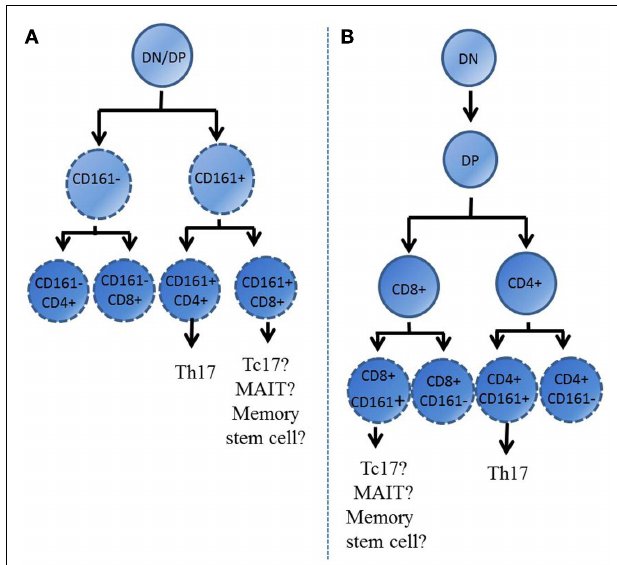
FIGURE 3 | Expression of CD161 early during the development ofT cells within the thymus. This figure illustrates two possible pathways by which CD161 expression may be determined during development; either before co-receptor expression is decided (A) or at the single positive stage, whenT cells are either CD4 + or CD8 + (B) .Th17 cells only develop from CD161 + CD4 + cells, however these cells can also develop intoTh1 orTh2 cells. DN, double negative; DP, double